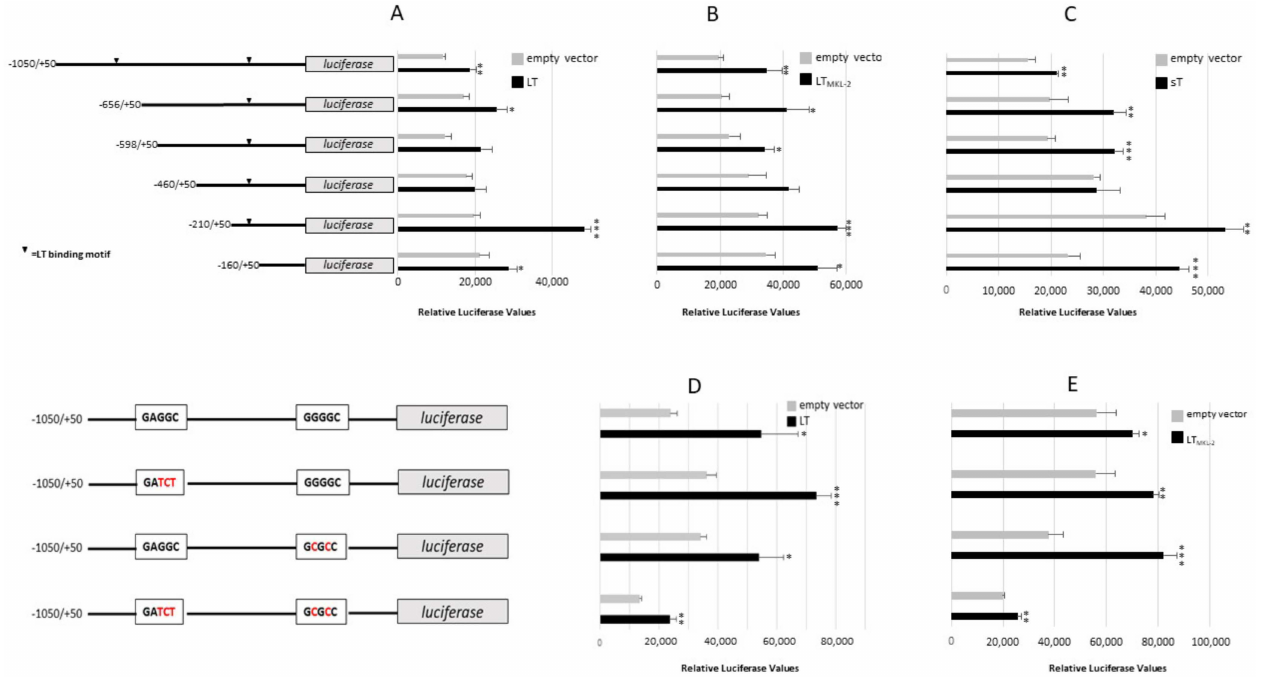
Figure 4. Effect of MCPyV LT and sT on the activity of IL-33 promoter mutants. ( A – C ) MCC-13 cells were co-transfected with a luciferase reporter plasmid containing the human IL-33 promoter encompassing sequences − 1050 to +50 or truncated version, together with an empty expression vector pcDNA3.1 (EV) or an expression of plasmid encoding MCPyV full-length LT ( A ), LT MKL-2 ( B ) or sT ( C ). ( D , E ) MCC-13 cells were co-transfected with a luciferase reporter plasmid containing IL-33 promoter sequences − 1050/+50, or with a mutation of either one or both potential LT binding sites, together with empty vector, LT ( D ) or LT MKL-2 ( E ). Mutated sequences are indicated in red. Luciferase values were normalized to the total protein concentration in the sample. Each bar represents the average ± SD of three independent parallels. Each experiment was performed 2 to 4 times, and similar results were obtained. * p < 0.05, ** p < 0.01; *** p <